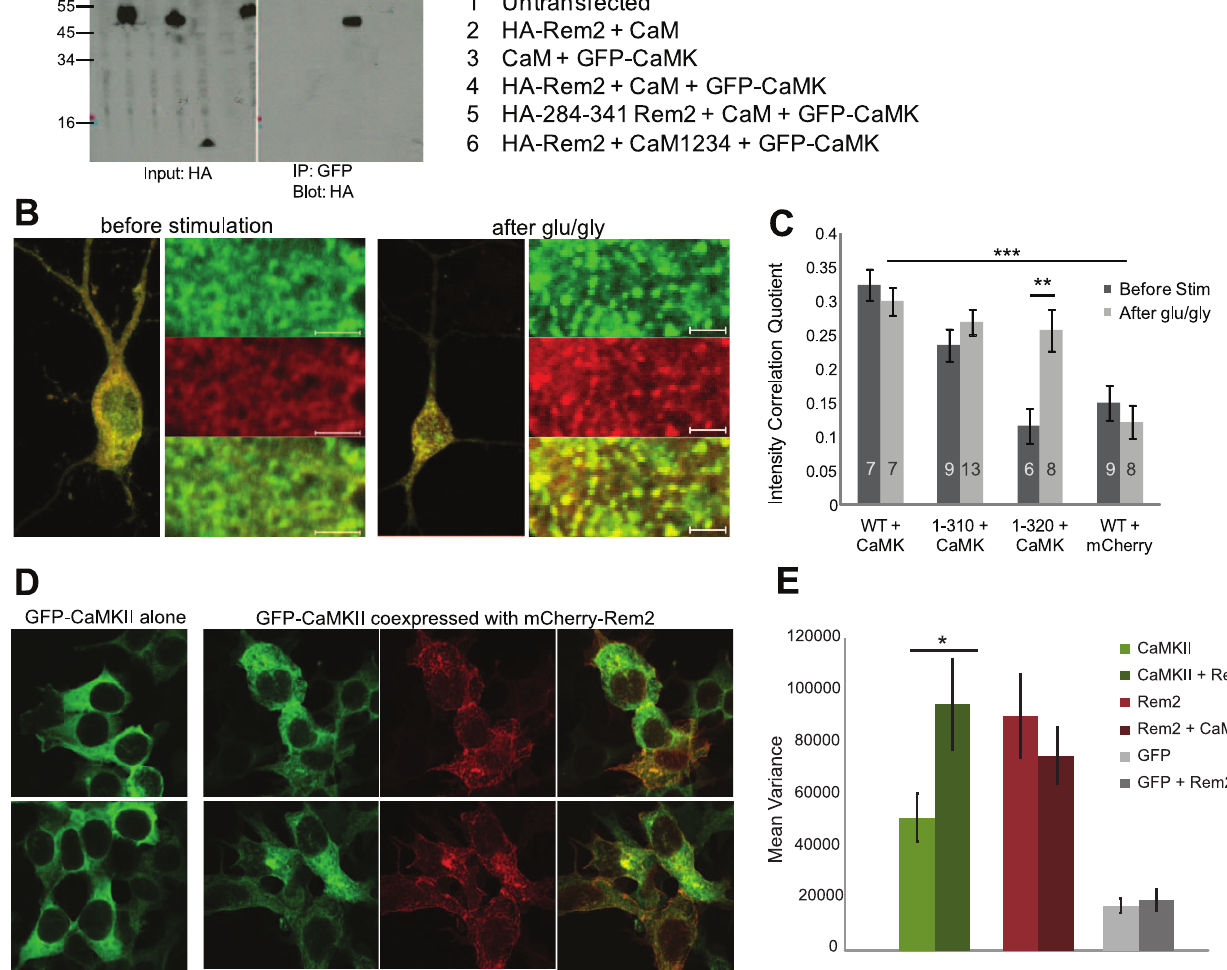
Figure 5. Rem2 interacts and redistributes with CaMKII. ( A ) Calcium-calmodulin is essential for Rem2-CaMKII association. HEK cells were transfected with the indicated GFP-CaMKII, CaM, the calcium-insensitive mutant CaM1234 or HA-Rem2 constructs. Cell lysates were coprecipitated with anti-GFP antibody coupled to proteinA/G beads. Coprecipitated proteins were eluted from beads in sample buffer and separated using 10%/ 16% tricine SDS-PAGE followed by Western blotting with anti-HA antibody. Precleared lysates ( left ) and coprecipitated proteins ( right ) are shown. CaMKII binds only to full length Rem2 (lane 4) and not to a C-terminal fragment of Rem2 (lane 5). CaMKII also shows no binding when Rem2 and CaMKII are coexpressed with CaM1234 (lane 6). ( B ) Fluorescent signals of GFP-Rem2 and mCherry-CaMKII redistribute together. Rem2 and CaMKII cotransfected neurons were fixed following no stimulation or 60 seconds of 100 m M glutamate/10 m M glycine stimulation and 5 minutes of recovery. Left subpanel of each panel shows a cell coexpressing CaMKII and Rem2. Right subpanel shows a higher resolution of the subcellular distribution of GFP-Rem2 (top), mCherry-CaMKII (center) and an overlay (bottom). Scale bars are 5 m m. ( C ) Rem2 and CaMKII are colocalized before (dark bars) and after (light bars) stimulation. Intensity correlation of GFP and mCherry signal is given for neurons coexpressing mCherry-CaMKII and GFP-Rem2 wild- type or C-terminal truncations. The higher the intensity correlation quotient (ICQ), the greater the covariance of the two colors across the cell, i.e. higher colocalization within the cell. Correlation of GFP-WT Rem2 and unconjugated mCherry is given as control. ICQ of GFP-WT-Rem2 + mCherry- CaMKII before stimulation, 0.312 6 0.015; GFP-WT-Rem2 + mCherry alone, 0.137 6 0.018; two-way ANOVA, p , 0.001. Only the constitutively punctate 1– 320 Rem2 mutant shows a different distribution from CaMKII before stimulation, although it correlates with CaMKII after. Before